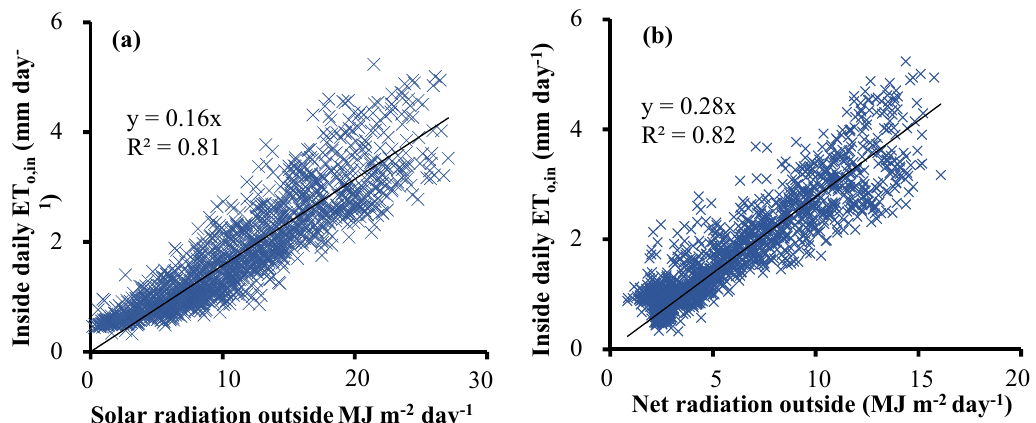
Figure 13. Relationship between inside reference crop evapotranspiration (ET o,in ) and outside solar radiation ( a ) and net radiation ( b ).